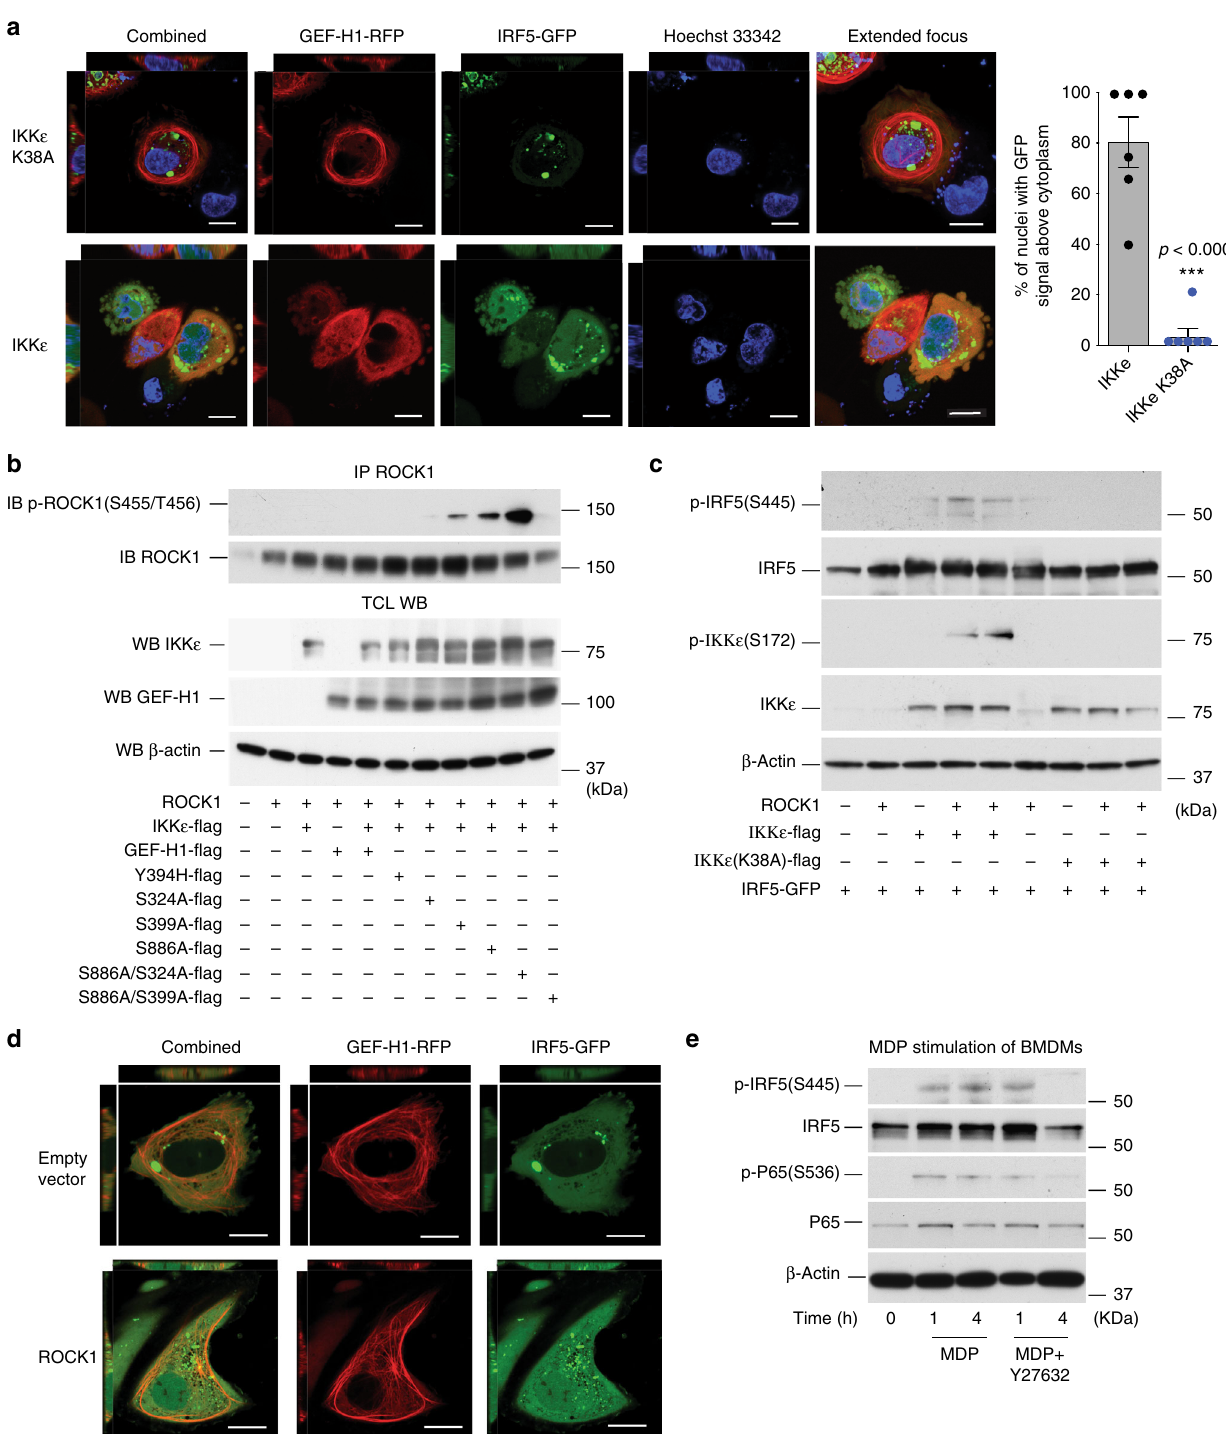
Fig. 4 ROCK1/2 is required for IKK ε and IRF5 activation. a Confocal microscopy analysis of primary human ARPE-19 cells 24 h after transfection with plasmids encoding GFP-tagged IRF5 and RFP-tagged GEF-H1 in presence of IKK ε or IKK ε (K38A) variant expressing constructs. Nuclear DNA was labeled using Hoechst 33342. Image acquisition was carried out with NIS-Elements imaging software (Nikon) followed by analysis by Volocity (PerkinElmer) to quantify the percentage of nuclei with GFP signal above cytoplasm in either IKK ε or IKK ε (K38A) transfected cells. Error bars indicate mean±SEM. Statistical signi fi cance was calculated using Student ’ s t -test *** P < 0.0001 ( n = 6). Scale bars, 10 µ m. b Immunoblot analysis of ROCK1 phosphorylation after immunoprecipitation with anti-ROCK1, in HEK293T cells co-transfected with ROCK1 and IKK ε plasmids in presence or absence of WT or GEF-H1 variants. c Western blot analysis of IRF5 and IKK ε phosphorylation in response to WT or variant (K38A) IKK ε expression in absence or presence of